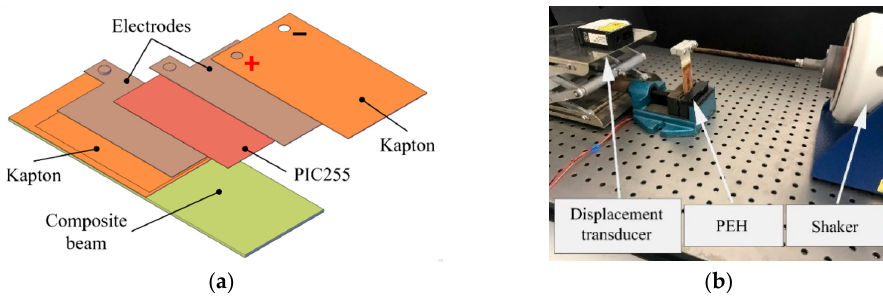
Figure 2. ( a ) Schematic drawing of the low-cost piezoelectric energy harvester (PEH) used in this work and ( b ) setup employed for its experimental characterization (the humidity generation chamber is not shown in this figure).